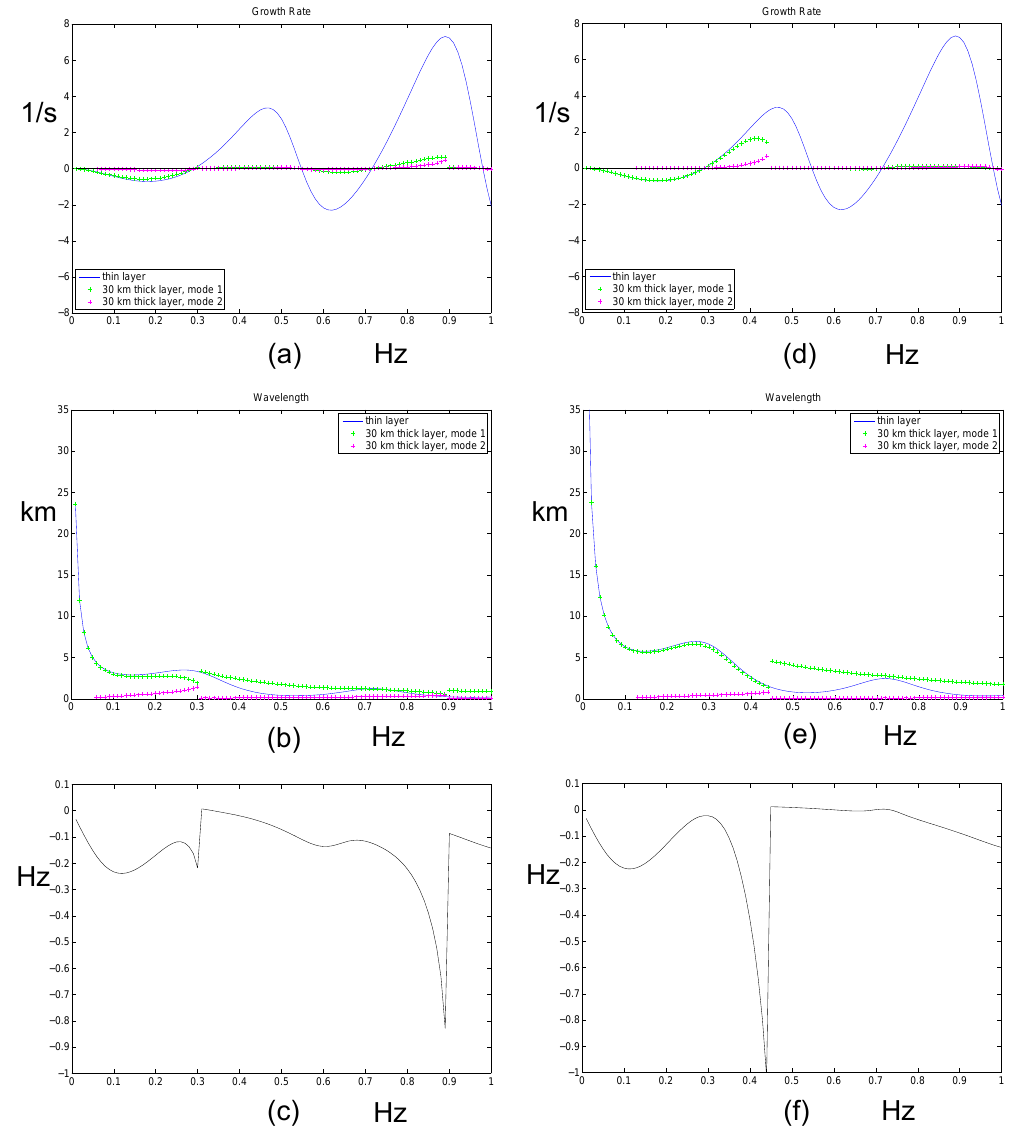
Fig. 6. Growth rate, wavelength, and frequency in the earth-fixed frame, plotted versus frequency in the frame moving with the E 0 × B velocity, for a 120km altitude layer. Panels (a) through (c) are for E 0 = 50 mVm − 1 . Panels (d) through (f) are for E 0 = 100 mVm − 1 . The green (purple) lines show results for the mode with the largest (second largest) growth rate for a 30km thick layer. The blue lines show results for a thin auroral layer of the same integrated conductivity. The results for the frequency in the earth-fixed frame (black lines) are shown only for the mode with the largest growth rate when the layer is 30 km thick (i.e., for the green lines). The integrated Pedersen and Hall conductivities are 2.27mhos and 9.05mhos, respectively, which corresponds to a 30km thick layer with an electron density of 10 11 m − 3